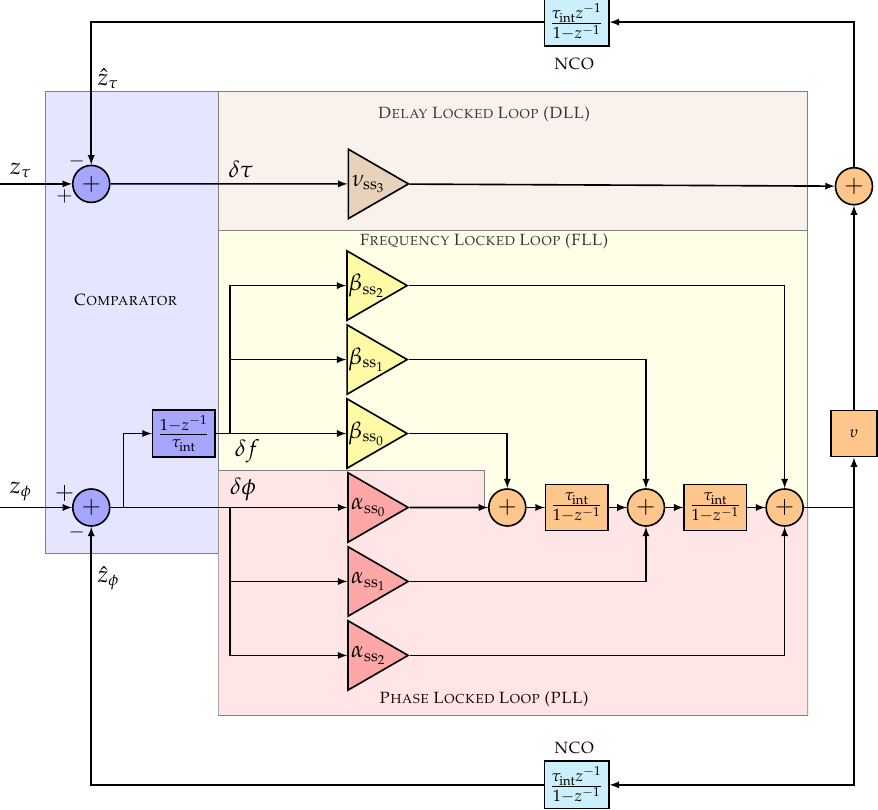
Figure 2. Linear model of full LUT-DSKF tracking